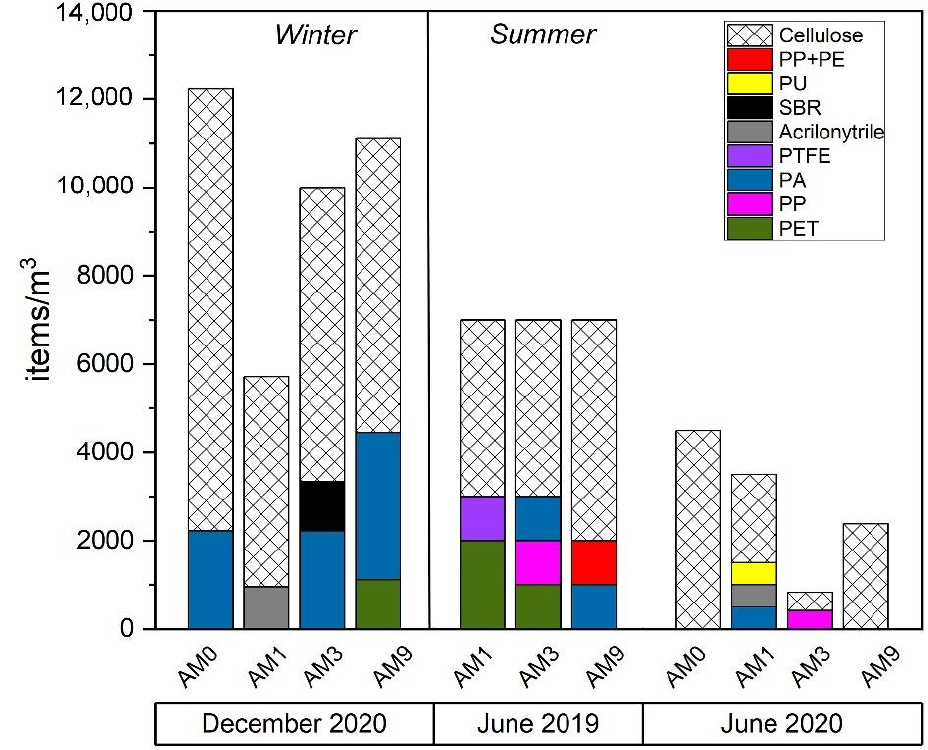
Figure 9. Classification of synthetic polymers in water samples. Natural polymers (cellulose) are also reported.